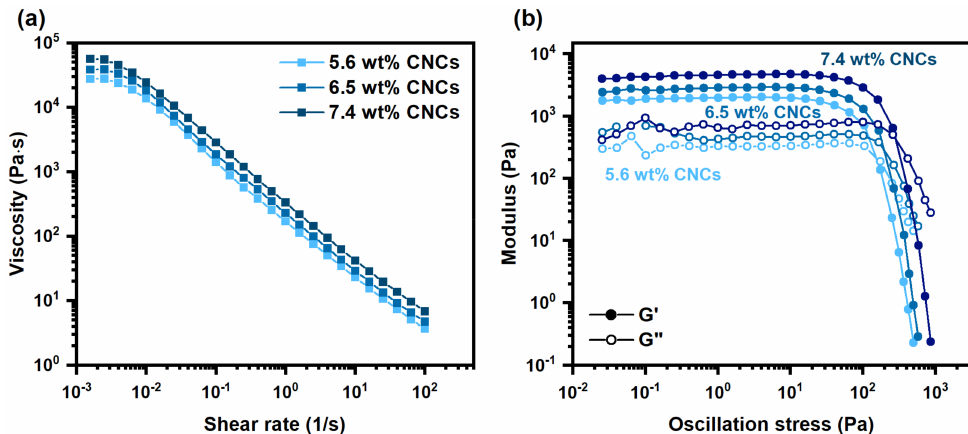
Figure 2. Rheological analysis of the PAAS/CNC inks under different concentrations of CNCs. ( a ) Steady-state shear viscosity of the inks. ( b ) Oscillatory rheological